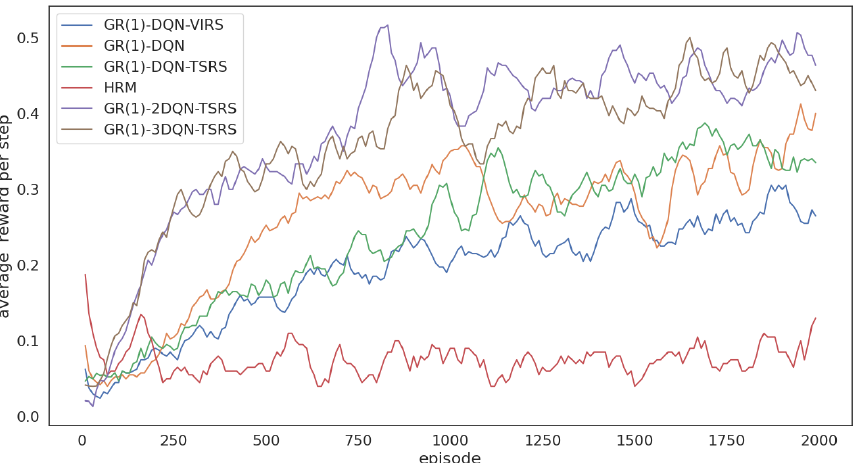
Figure 12. Comparison of learning curves for multi-task reinforcement learning algorithms with ϕ 2 under stochastic environment setting 2.